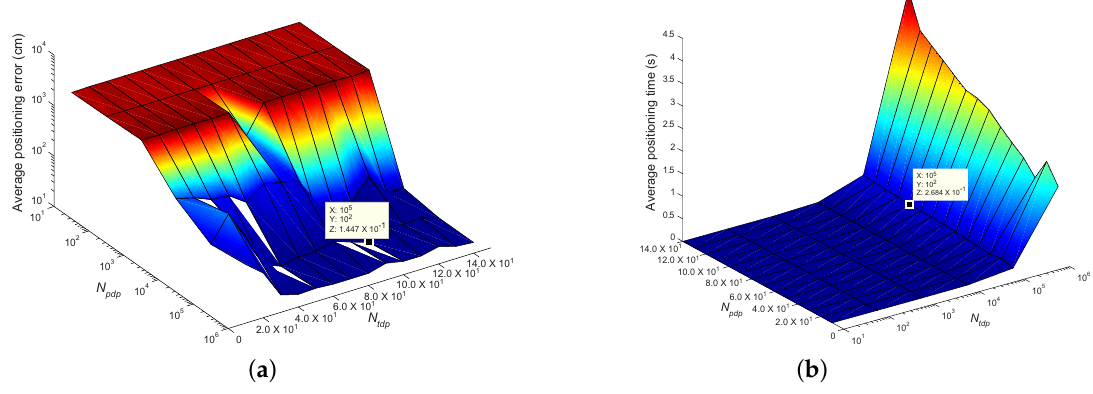
Figure 9. Positioning experiment results of test cases TC1 and TC2 executed by positioning scheme DRC3 using DSPF for the values between N pdp ⊂ { 10,140 } and N tdp ⊂ { 10 1 ,10 6 } ; ( a ) Curve of the average positioning error and ( b ) Curve of the average positioning time. Text annotations on the curves indicate optimal values of N pdp = 10 2 and N tdp = 10 5 that can achieve a high degree of positioning accuracy at little computational cost in TC1 and TC2.